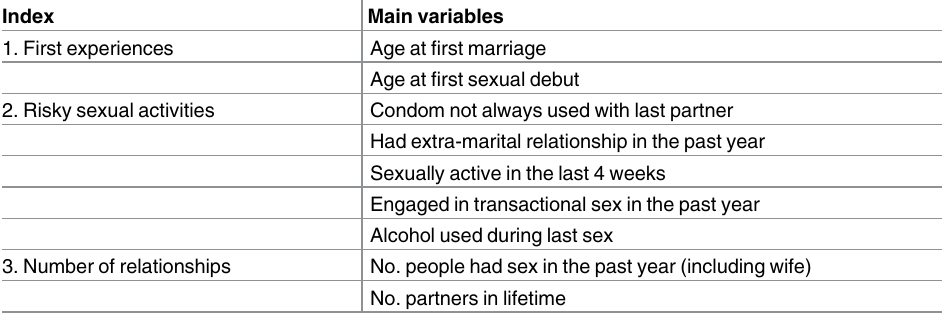
Table 1. Mean effect analysis: List of